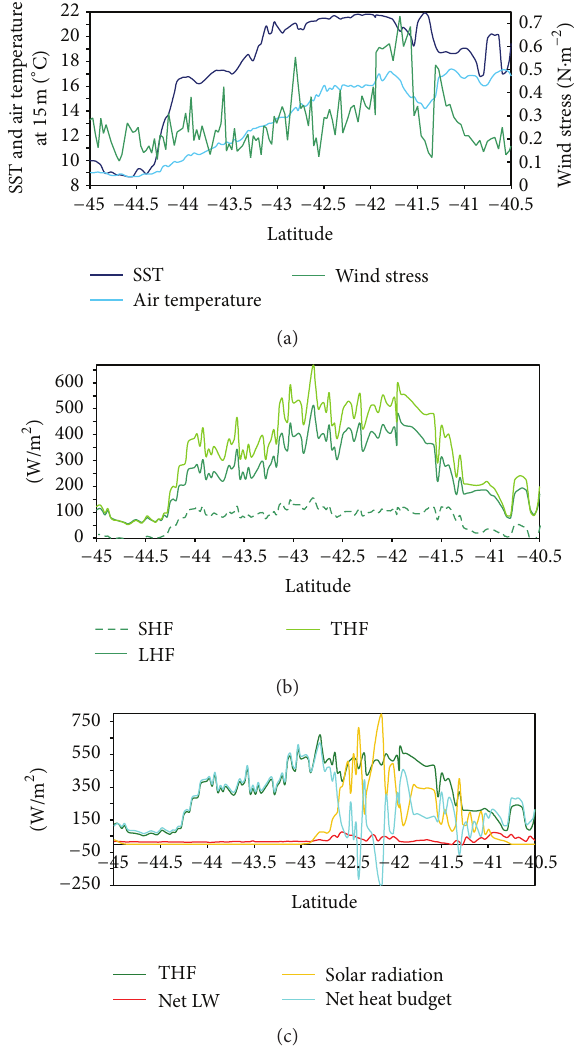
Figure 4: From left (south) to right (north) along the transect: measured SST, air temperature, and wind stress (a); derived sensible heat fluxes (SHF), latent heat fluxes (LHF), and turbulent heat fluxes (THF) (b); turbulent heat fluxes (THF), net longwave radiation, solar radiation, and net heat budget